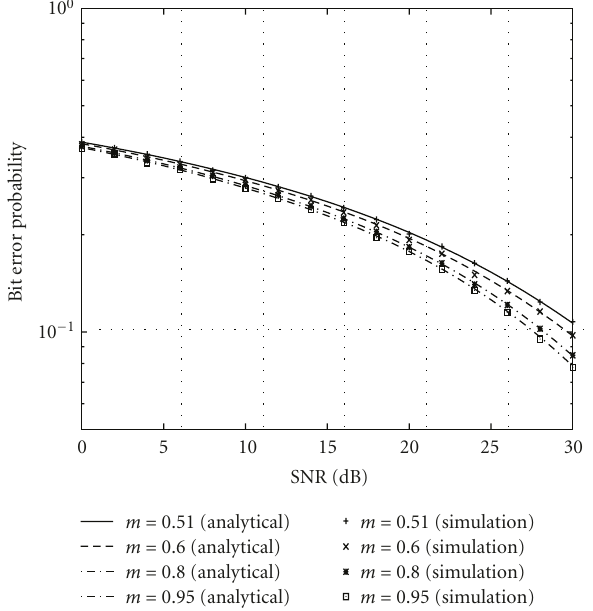
Figure 7: BEP for M -PAM subject to Nakagami- m fading for m = 3 . 50 and di ff erent values of M